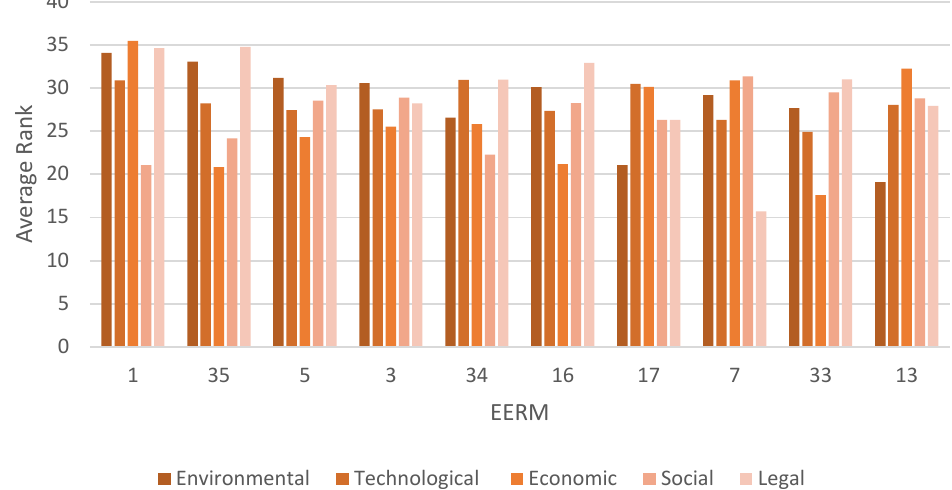
Figure 4. Ranking of alternative per Motivation. 1: Maintenance_Wall, 35: Maintenance_Envelope